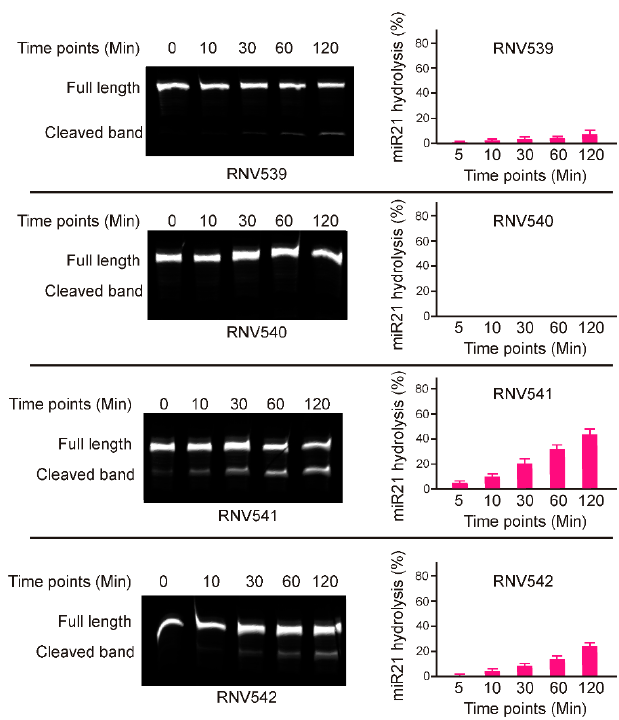
Figure 2. In vitro miR-21 RNA template cleavage assay using the designed synthetic antimiRzymes. Synthetic miR-21 RNA template was incubated with 100 nM antimiRzymes at 37 °C. The reactions were terminated by adding formamide solution at the indicated time points. The products were then separated on a 15% denaturing polyacrylamide gel and visualized using Fusion FX Bilber Lourmat imager. The densitometry analysis was performed using the ImageJ program.